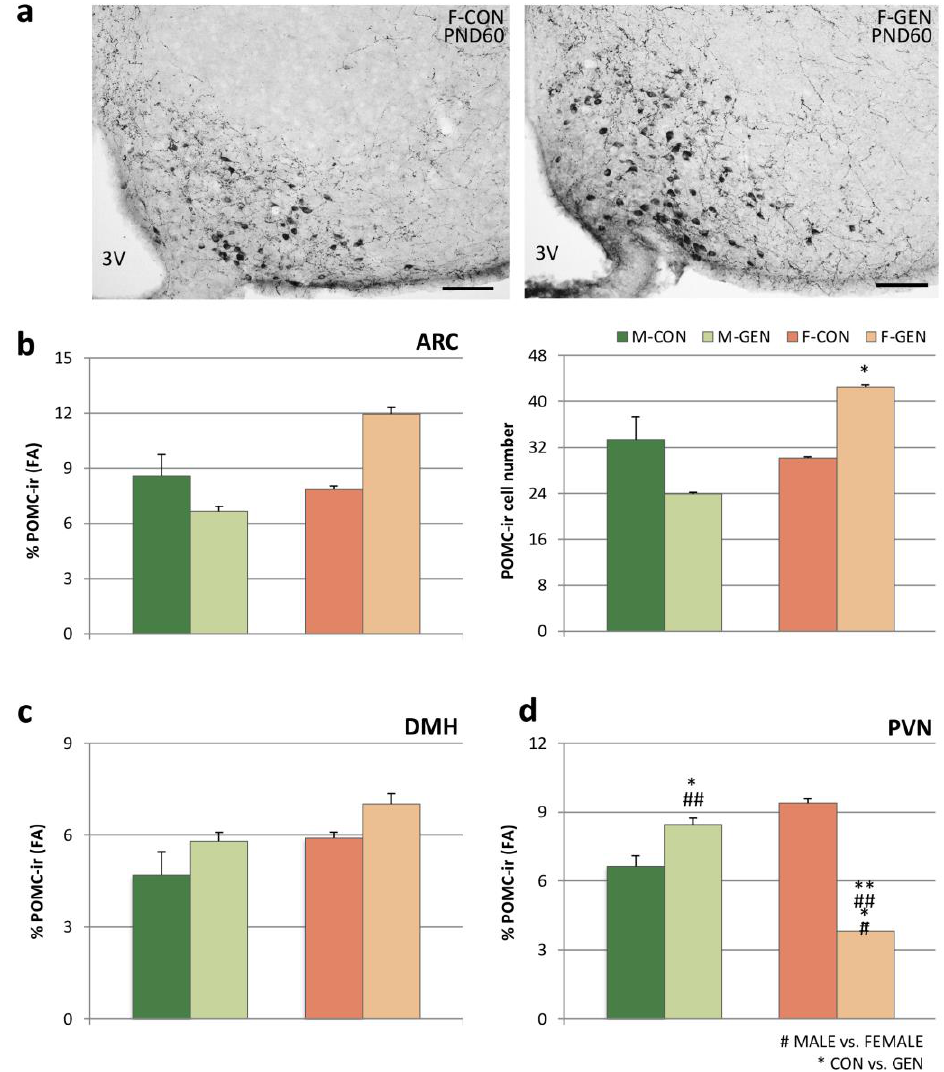
Figure 9. Pro-opiomelanocortin (POMC) immunoreactivity. ( a ) Photomicrographs of the arcuate nucleus (ARC) immunostained for POMC at PND60 in control (F-CON) and treated (F-GEN) female mice. 3V, third ventricle. Scale bar = 100 µm. ( b ) Variations of both the percentage of area (FA: mean ± SEM) covered by POMC immunopositive structures (left) and the number of positive cell bodies (right) in the ARC of both sexes (M-CON, M-GEN, F-CON, F-GEN) for adult mice. ( c , d ) Histograms representing the FA (mean ± SEM) covered by POMC immunoreactivity within ( c ) the dorsomedial hypothalamic nucleus (DMH) and ( d ) paraventricular nucleus (PVN). * p < 0.05; ** p < 0.01; ## p ≤ 0.001 (Bonferroni test).